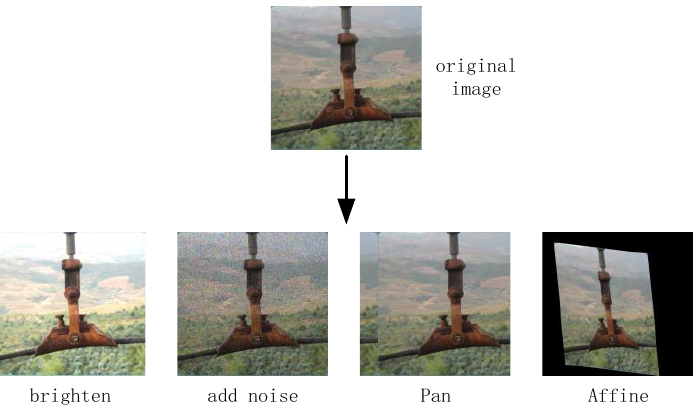
Figure 6. Image enhancement results.